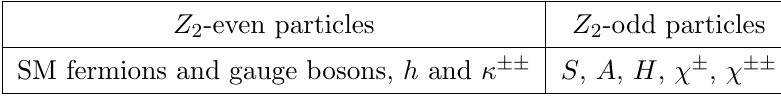
Table 2 . Z 2 parity assignments to the physical particles in our